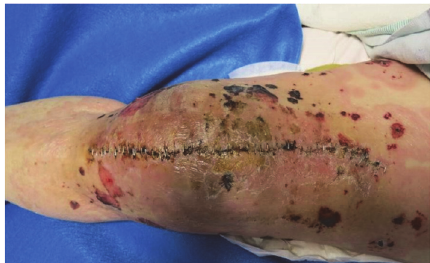
Figure 1: Left knee with peri-incisional crusting, coalescing, salmon-colored plaques.